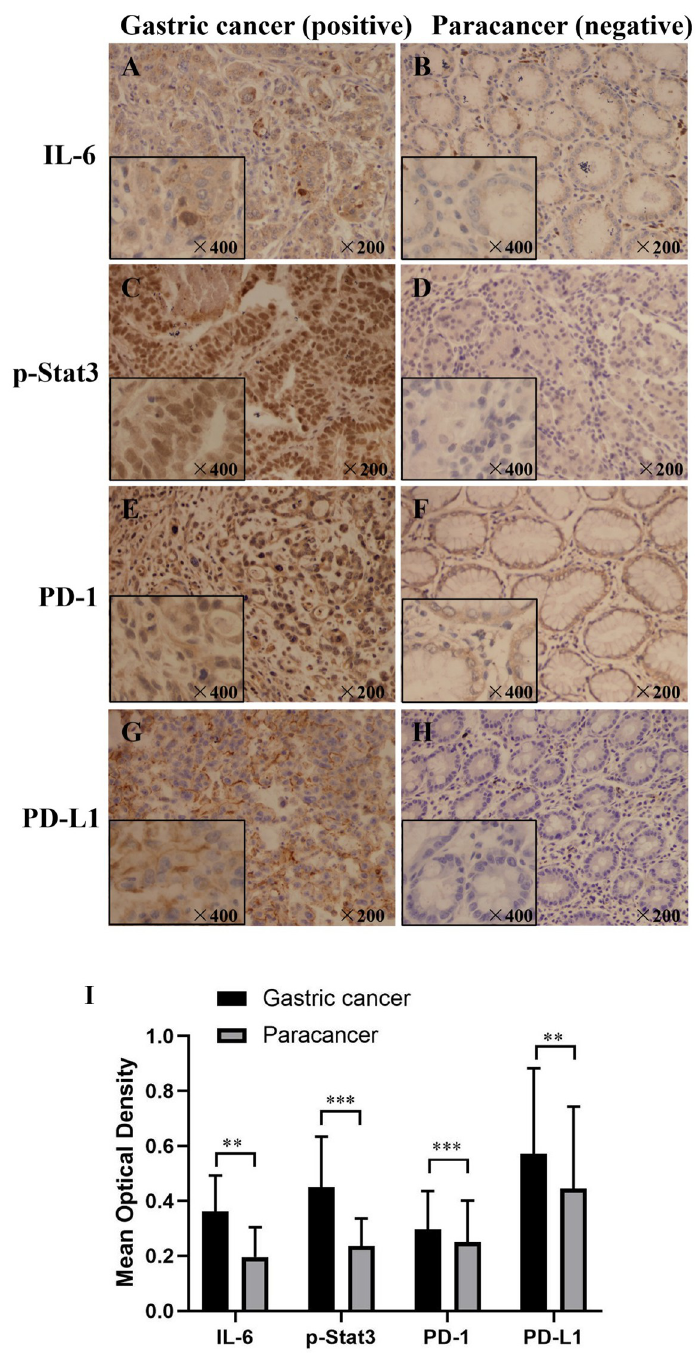
Fig 1. Expression of IL-6, P-Stat3, PD-1 and PD-L1 in GC and paracancerous tissues. (A), (C) and (G) were the positive expressions of IL-6, P-Stat3 and PD-L1 in gastric cancer tissues respectively(Envision × 200); (E) was positive expression of PD-1 in gastric cancer interstitial infiltrating lymphocytes(Envision × 200); (B), (D) and (H) were negative expressions of IL-6, P-Stat3 and PD-L1 in paracancer tissues respectively(Envision × 200); (F) is negative expression of PD-1 in gastric cancer interstitial infiltrating lymphocytes(Envision × 200); (I) Each image is partially enlarged at the bottom left (Envision × 400). The quantification is representative of the optical density in 5 fields ± SD by random. �� P < 0.01, ��� P <